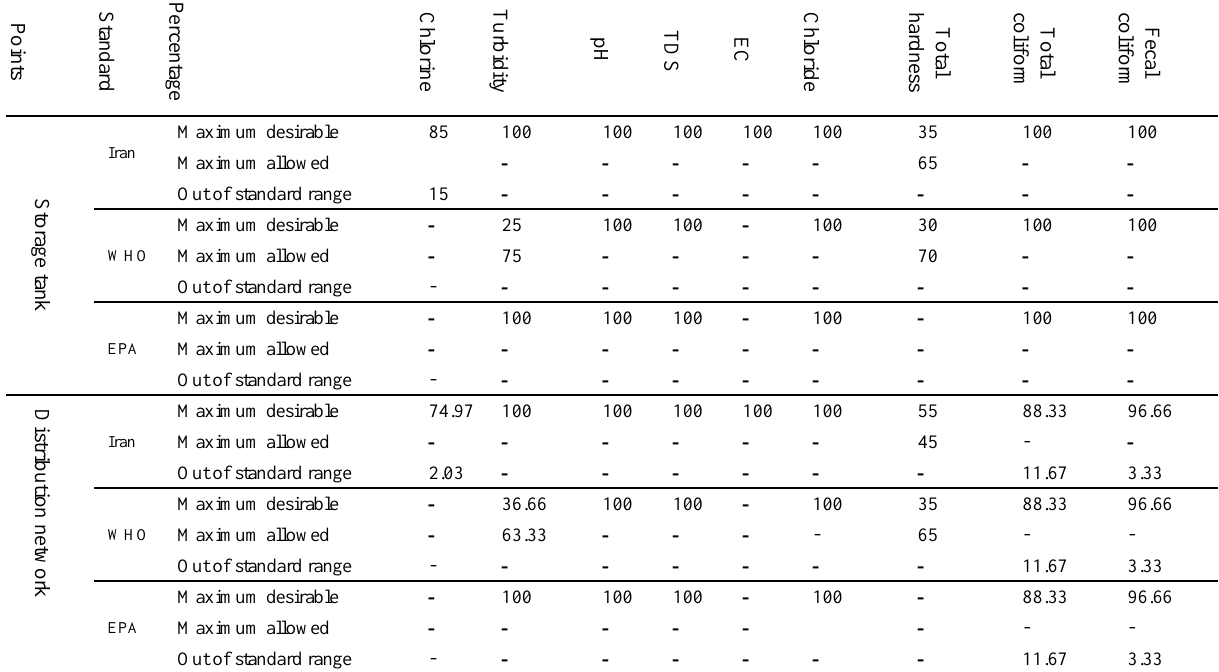
Table 3. Compliance rate of examined parameters with national and international